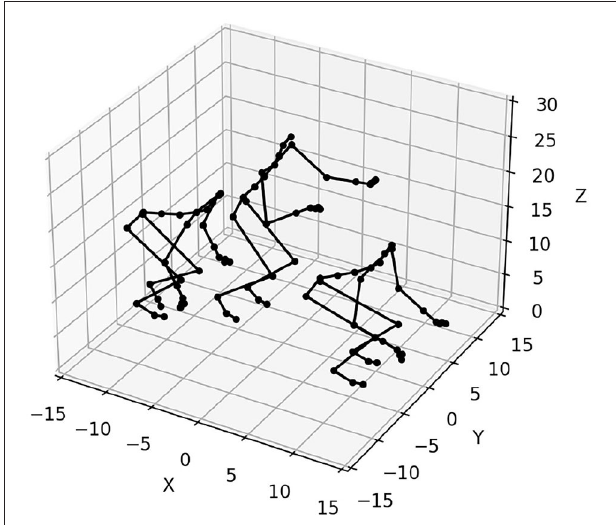
FIGURE 1 | Three body configurations taken from a trajectory capturing a jump motion.